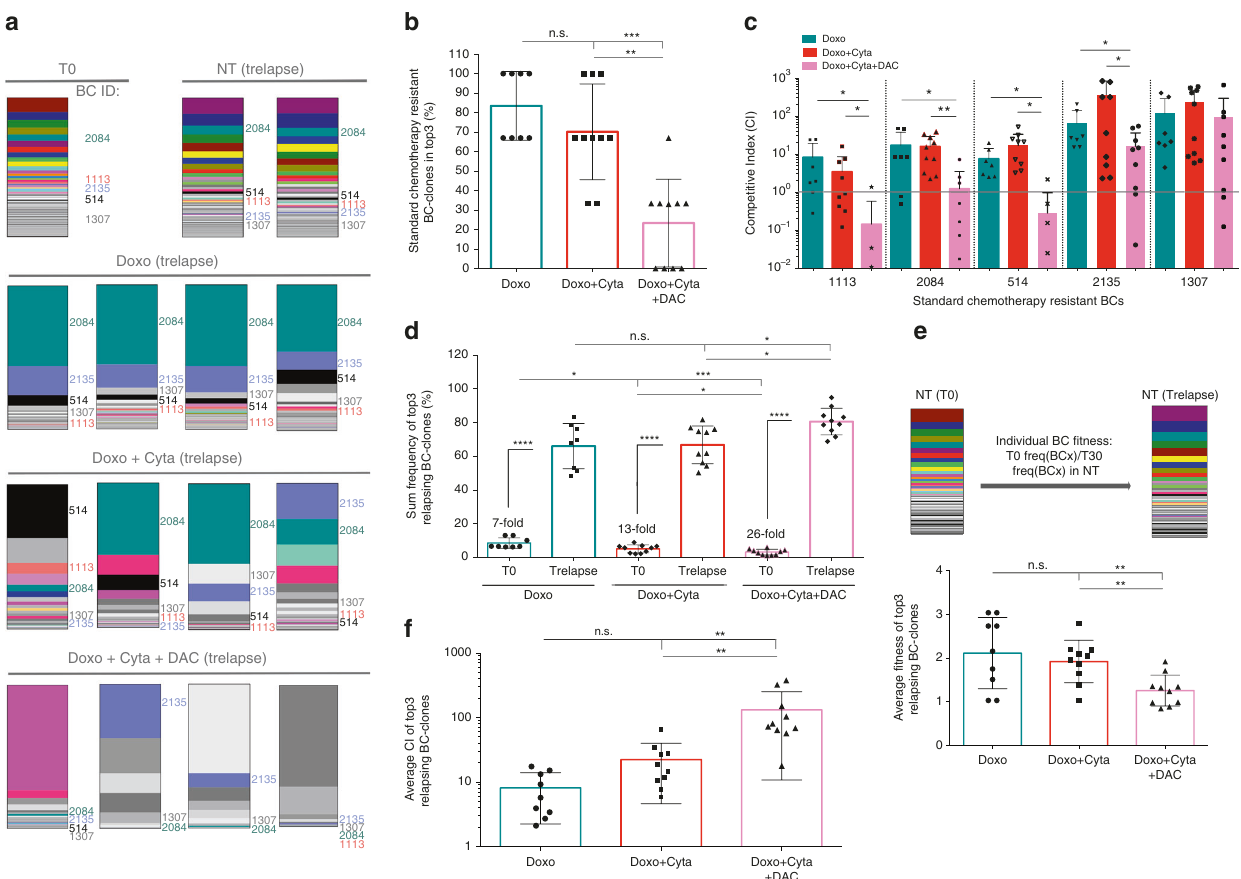
Fig. 3 Decitabine combination suppresses the re-growth of chemoresistant BC-clones. (Data relative to HEL cell line) a BC-clonal composition of representative NT, Doxo, Doxo + Cyta and Doxo + Cyta + DAC samples at Trelapse. Each BC-clone has a fi xed color-code across all samples. Chemoresistant BC-clones are indicated. b Average frequency at which chemotherapy-resistant BC-clones constitute the top 3 most dominant clones at Trelapse. In total, 3 out of 3 represents 100% frequency, 2 out of 3: 67%, 1 out of 3: 33% and 0 out of 3: 0% (Doxo: n = 8, Do33xo + Cyta±DAC: n = 10). c . Competitive index (CI) of each chemoresistant BC-clone in Doxo ( n = 8), Doxo + Cyta ( n = 10) and Doxo + Cyta + DAC ( n = 10) groups. A CI of 1 (dotted line) represents a similar barcode fold variation form T0 to Trelapse in the indicated condition relative to NT. d Summed frequency of top 3 most dominant BC-clones in each treatment group at Trelapse and their matched frequency at T0. The fold variation of the summed frequency of these BC-clones between T0 and Trelapse is indicated. e . Schematic representation of experimental approach to calculate BC-clone speci fi c fi tness. Lower graph — Average fi tness of the top 3 most dominant BC-clones from indicated groups (Doxo: n = 9, Doxo + Cyta±DAC: n = 10). f Competitive index (CI) of the top 3 most dominant BC-clones in indicated groups at Trelapse (Doxo: n = 9, Doxo + Cyta±DAC: n = 10). Graphs of mean±s.d., P values were determined by t-test (panel c.)one-way ANOVA test. ns – not signi fi cant, * P <0.05; ** P <0.01; *** P <0.001; **** P <0.0001. Source data are provided as a Source Data fi